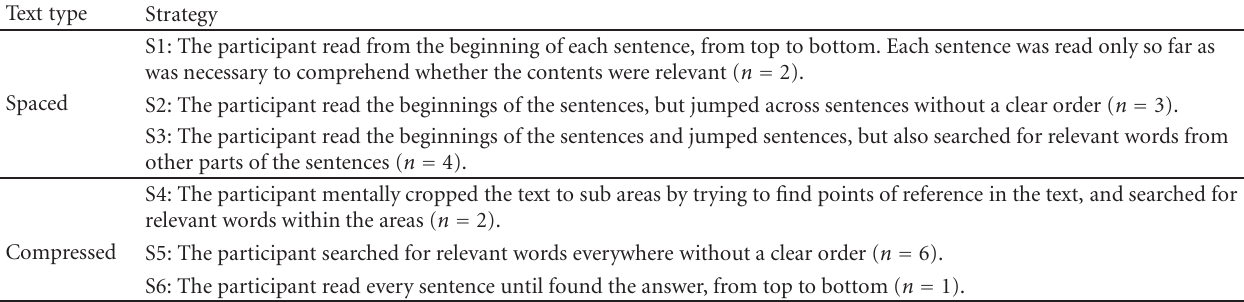
Table 3: Subjectively Reported Visual Sampling Strategies of the Participants in the Experiment